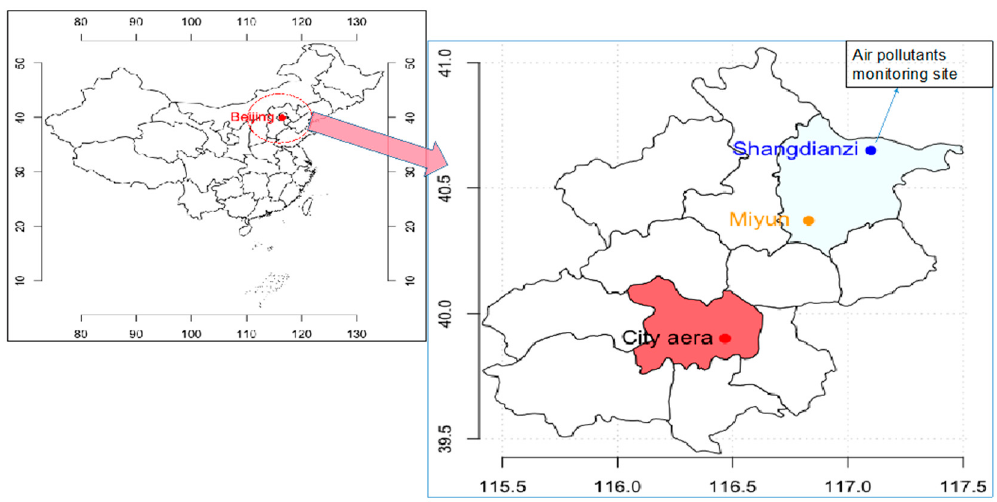
Figure 1. Study area. Red indicates Beijing city districts; light blue indicates Miyun County.